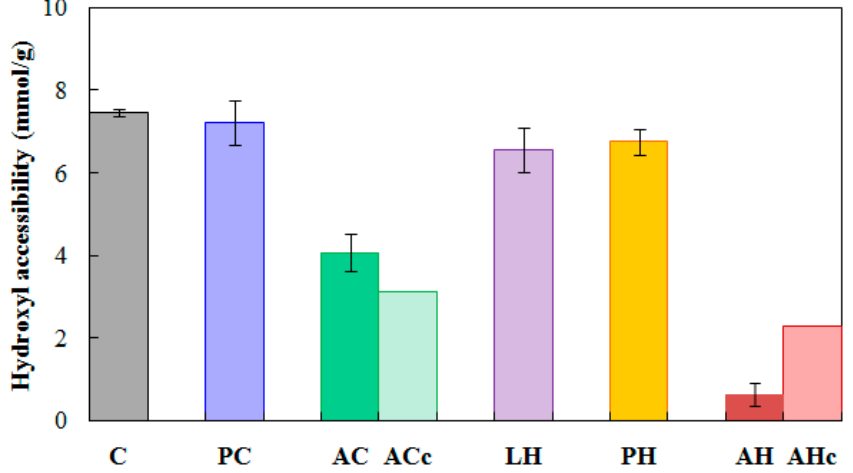
Figure 4. Hydroxyl accessibility of differently treated wood. ACc: the calculated hydroxyl accessibility of AC. AHc: the calculated hydroxyl accessibility of AH.